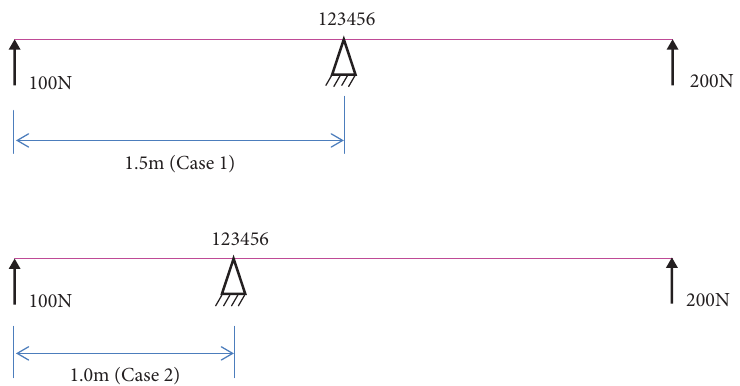
Figure 4: Finite element models for two cases.